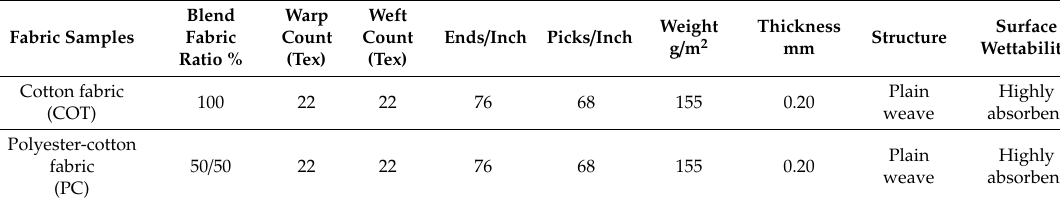
Table 1. Fabric construction and surface wettability of fabric samples.